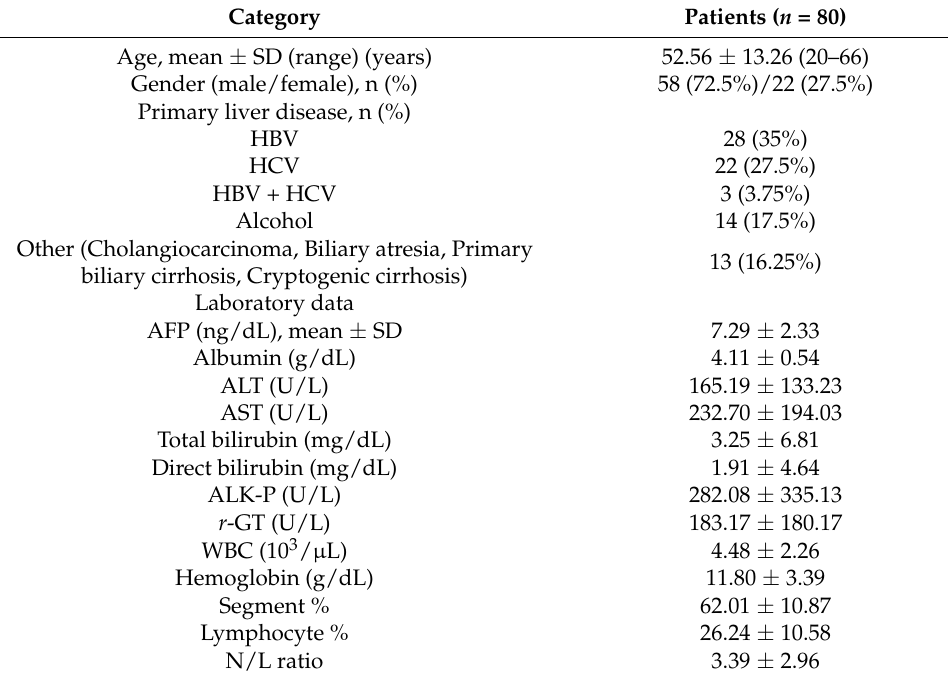
Table 1. Profiles of the 80 recipients with acute jaundice after living donor liver transplantation. Category Patients ( n = 80) Age, mean ± SD (range) (years) 52.56 ± 13.26